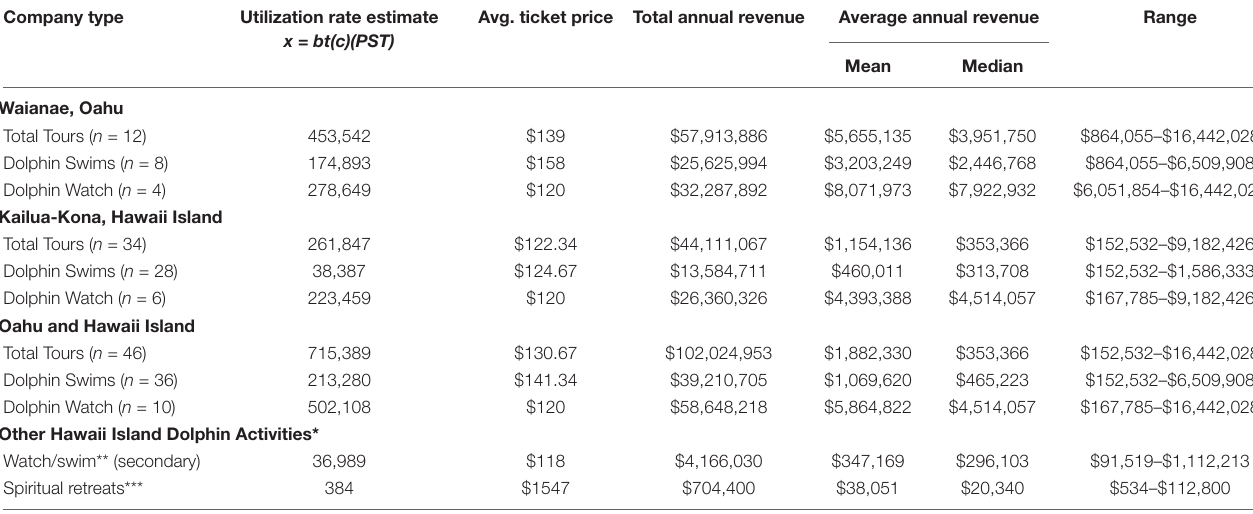
TABLE 3 | Commercial boat-based dolphin-swim direct revenue estimates by operator categories. Company